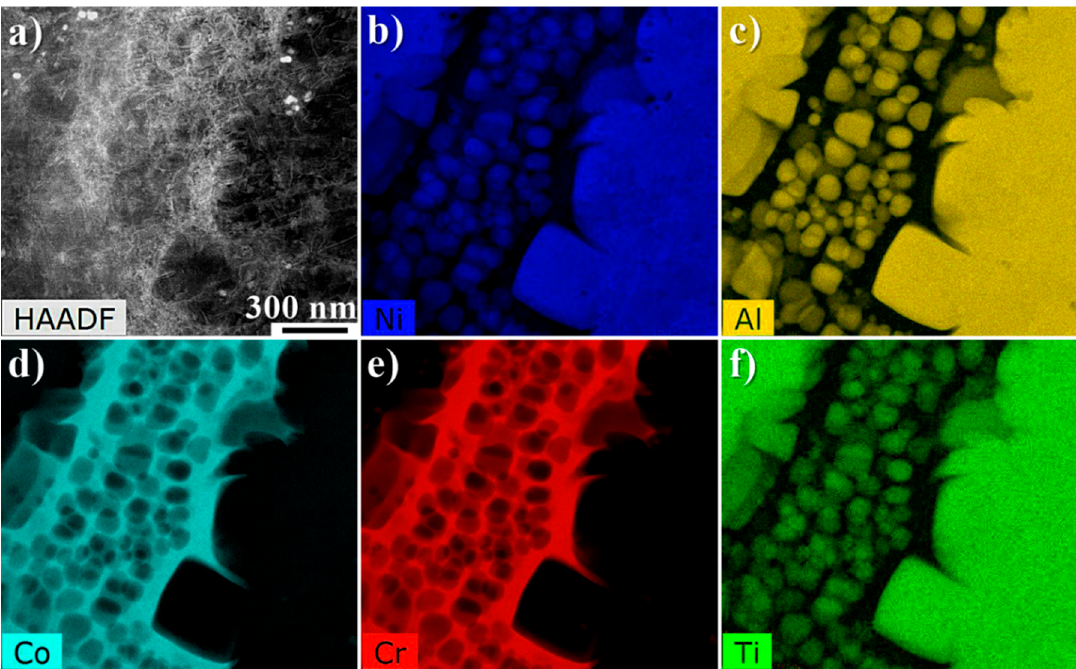
Figure 6. STEM ‐ EDX mapping comprising both dendritic regions and interdendritic spaces: ( a ) selected region for the STEM ‐ EDX mapping; ( b – f ) distribution of selected alloying elements in the γ matrix and γ ' precipitates.